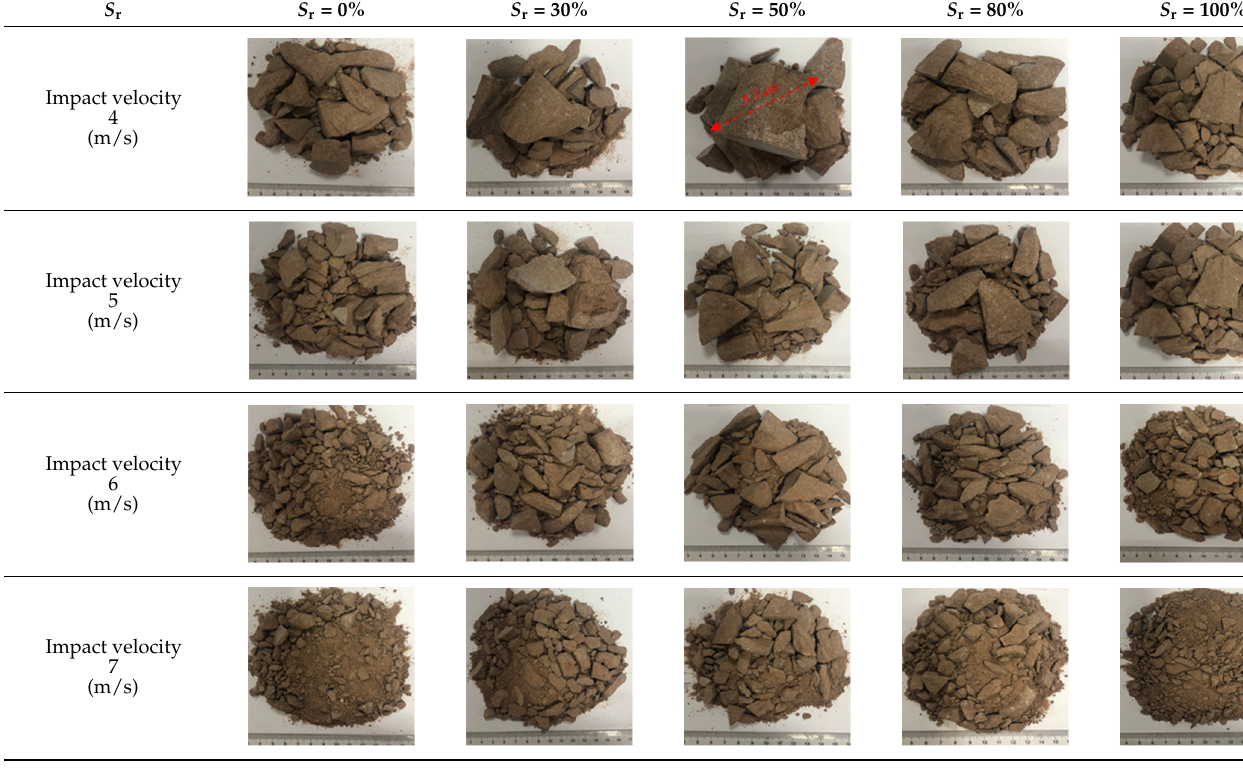
Table 3. Impact failure modes of the frozen sample.